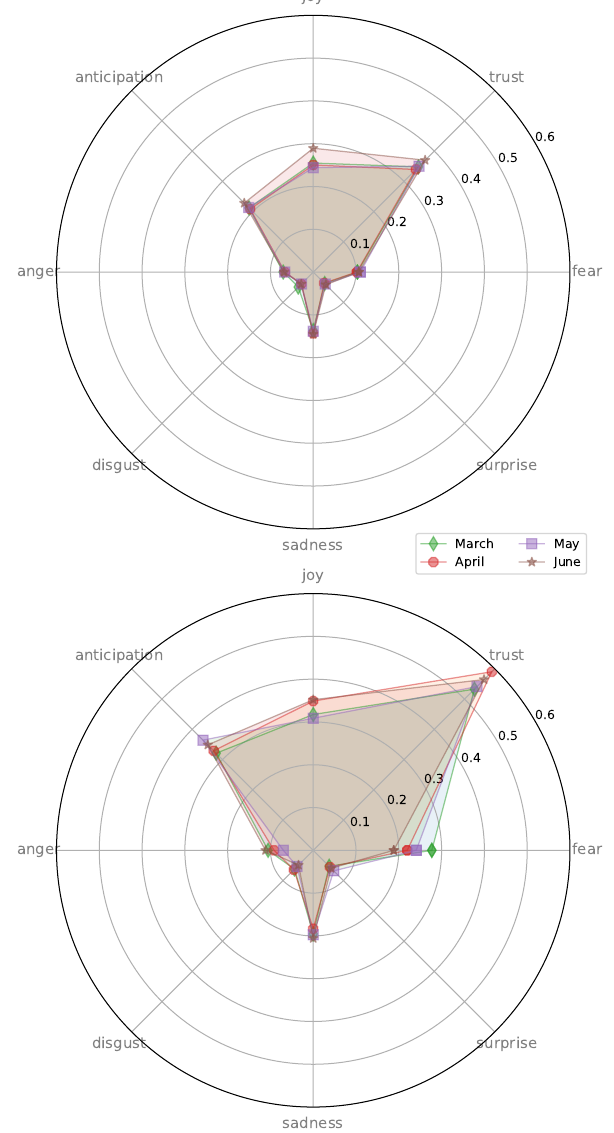
Figure 17. Radar plot of most expressed emotions in The Netherlands per month for both 2019 ( top ) and 2020 ( bottom )